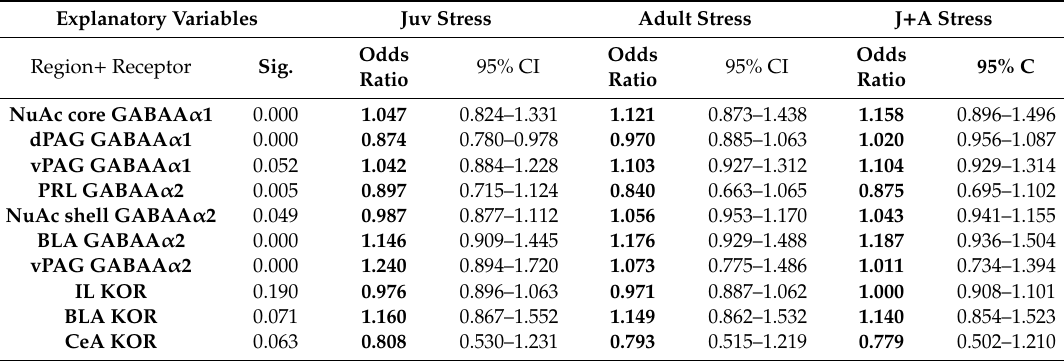
Table 2. Odds ratio for multinomial logistic regression